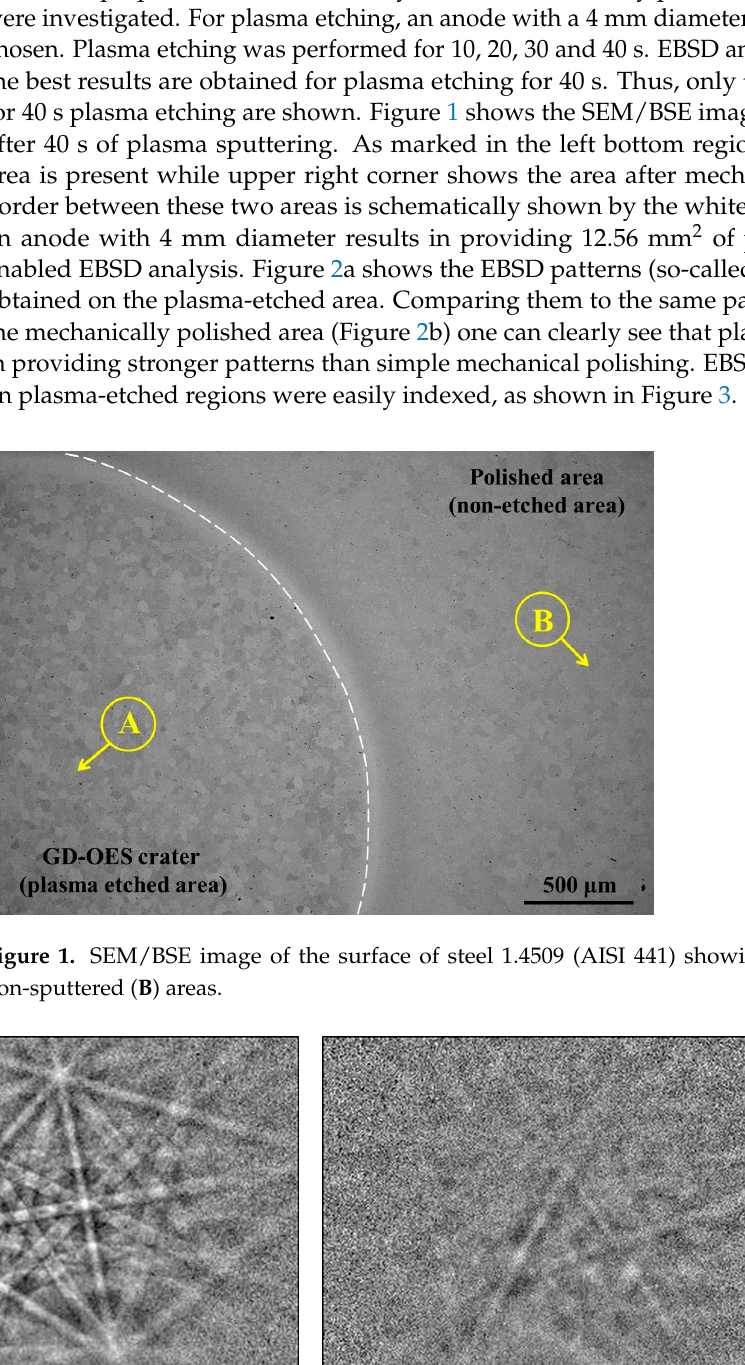
Table 1. Chemical composition of studied materials in wt %.